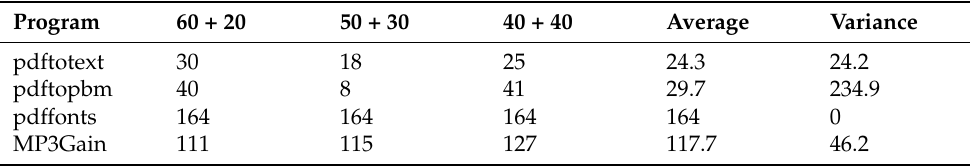
Table 7. Average and variance of unique